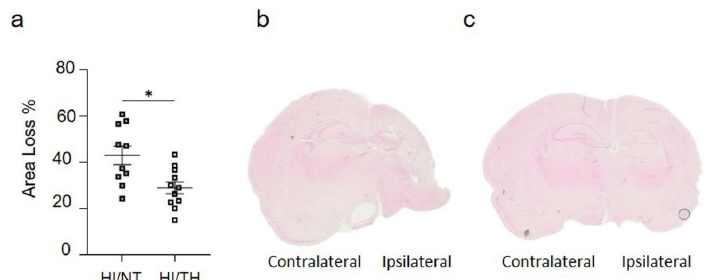
Figure 2. ( a ) Hemispheric area loss (%). P7 rat pups underwent ligation of the left carotid artery followed by 90 min of hypoxia. Pups were randomized to either 5 h of NT (37 °C) or 5 h of TH (32 °C) after hypoxia and were sacrificed after 7 days of survival. Therapeutic hypothermia significantly reduced brain area loss. ( b , c ) Representative image of coronal section from NT brain ( b ) and TH brain ( c ) staining with eosin showing the damage over the ipsilateral side on the NT treatment compared to TH treatment. n = 21 animals (n = 10 NT and n = 11 for the TH group). Student’s t -test was performed with a * p < 0.05. Data are expressed as median (interquartile range).